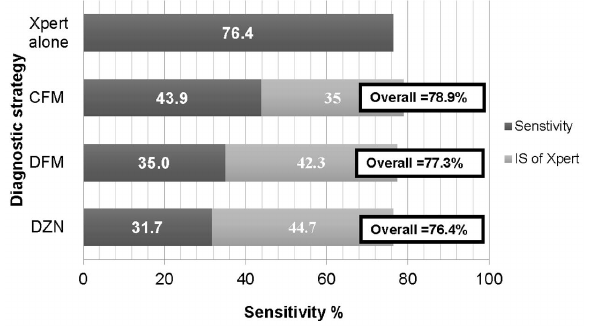
Figure 2. Sensitivity and incremental sensitivity of Xpert among smear negative MGIT culture confirmed TB cases (n=123). DZN = Direct Zielh Neelsen, DFM = Direct Fluorescent Microscopy, CFM = Concentrated Fluorescent Microscopy, Xpert = Xpert MTB/RIF test, IS = Incremental sensitivity.